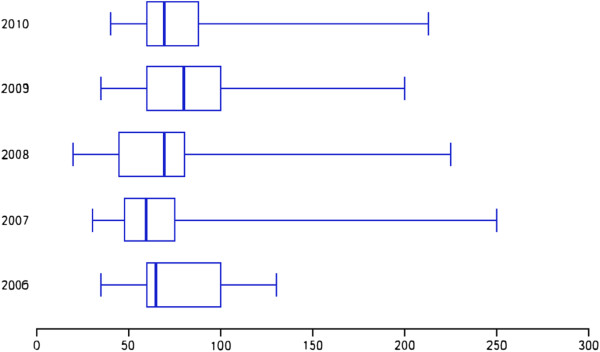
Box plots of operation time (min) over the 5-year study period.